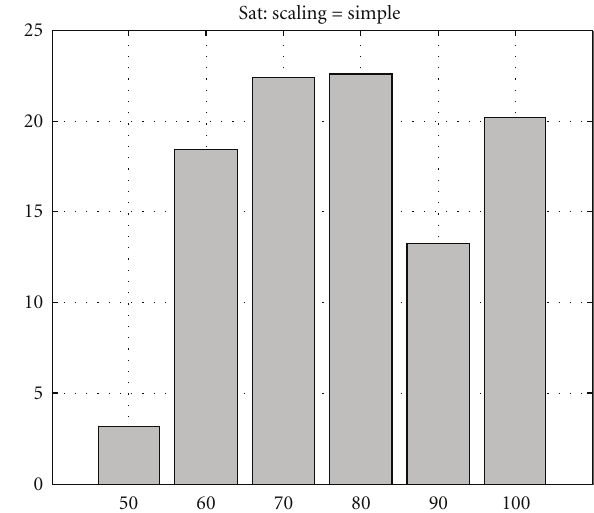
Figure 10: Satisfaction histogram for priority-oriented scaling scheme.